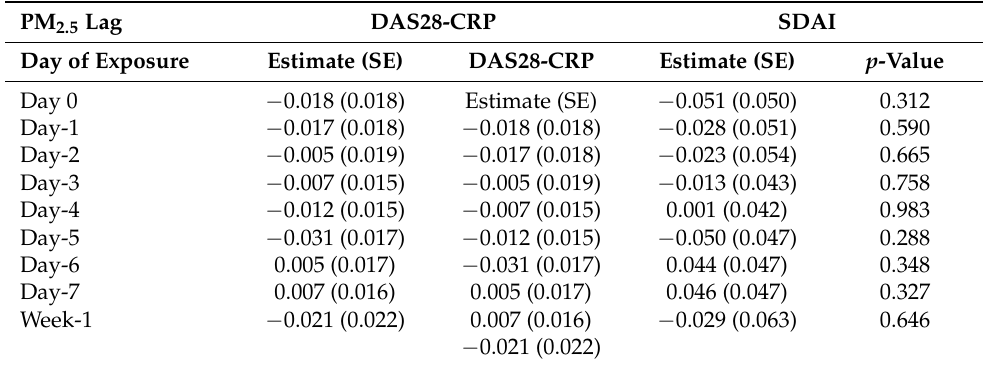
Figure 1. Graphical representation of PM 10 , PM 2.5 , NO 2 , and O 3 concentration levels. Table 2. Associations between PM 2.5 short-term exposure and RA disease